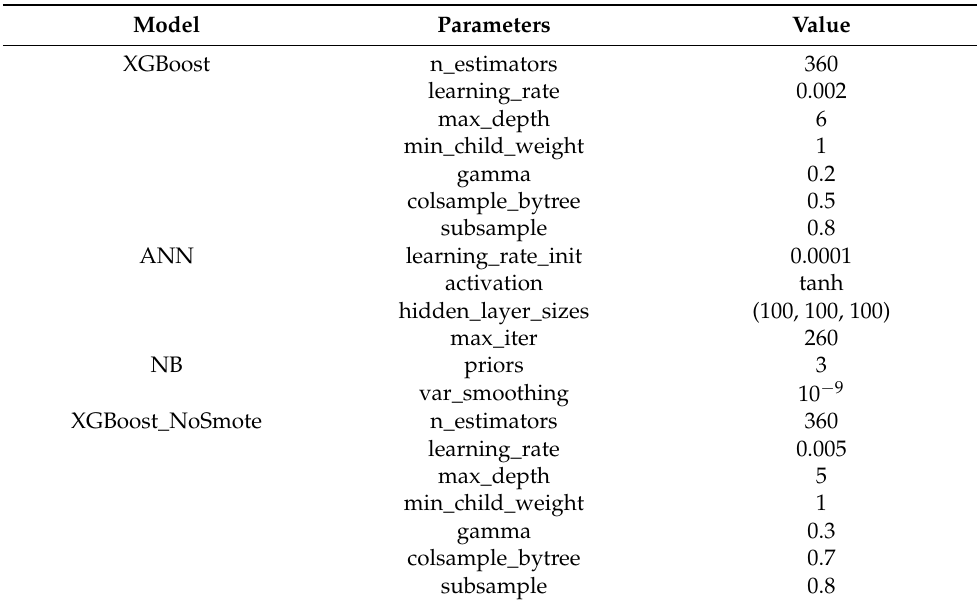
Figure 9. Flow chart of proposed method. Table 2. Optimal parameters of models.